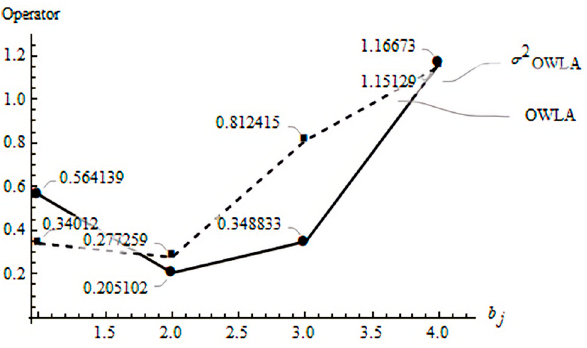
Figure 4. OWLA and 𝜎 (cid:2870) (cid:2899)(cid:2907)(cid:2896)(cid:2885) operators following conditions in Example 1. Figure 4. OWLA and σ 2 OWLA operators following conditions in Example 1.